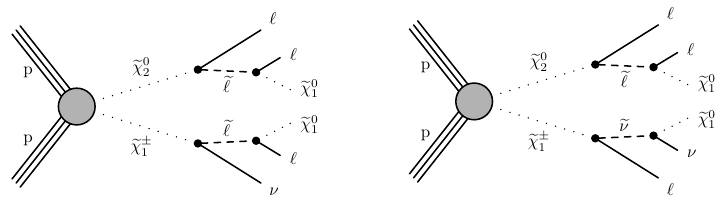
0 with subsequent decays via sleptons (left) and a slepton and a 2 1 e c